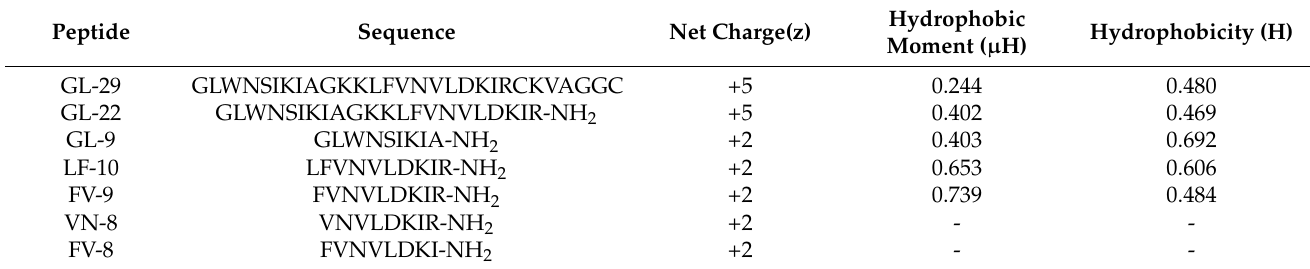
Table 1. Physicochemical parameters of GL-29 and its truncated analogues.